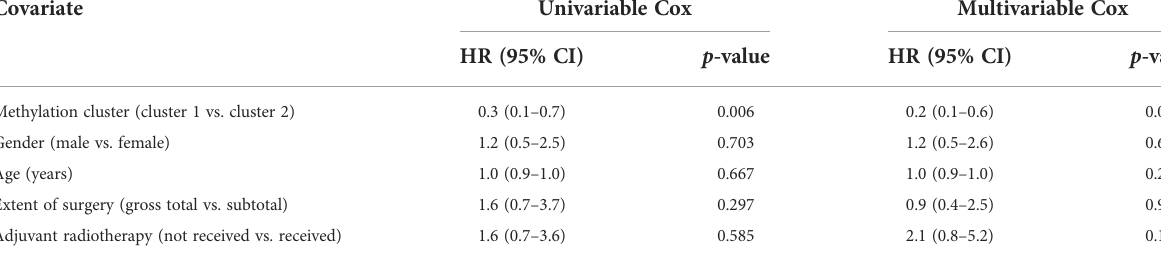
TABLE 2 Multivariable Cox analysis of the methylation cluster and clinical features.